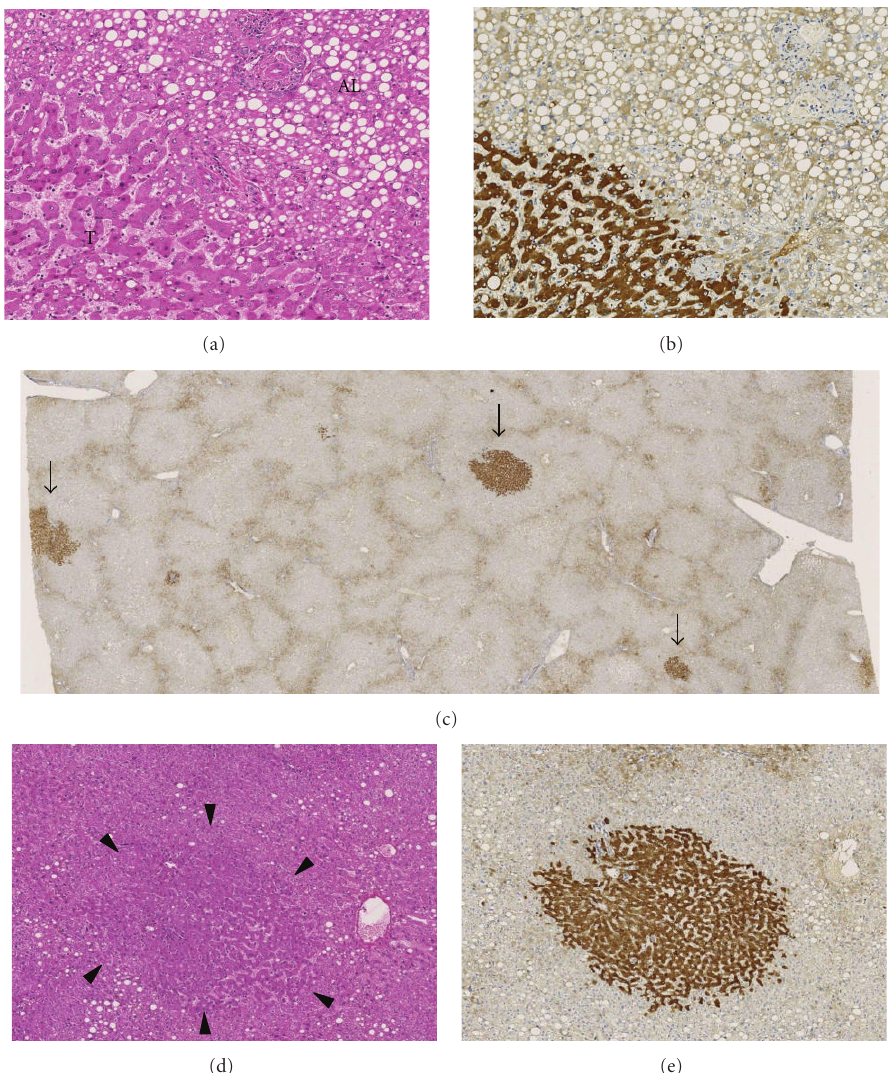
Figure 3: CRP expression in the transitional area and minute CRP-positive foci in a distant sample. (a) The transitional zone of an adenoma without steatosis (T) and steatotic adjacent liver (AL) in hematoxylin-eosin (HE) staining. (b) The same area as (a) in CRP immunostaining showing di ff use increase of CRP in the tumor part. (c) CRP immunostaining of a nontumorous liver sample distant from the tumor showing 3-minute CRP foci (arrows). The preserved architecture of the hexagonal liver lobules is highlighted by the vague expression of CRP which outlines the peripheral boundaries of the lobules. (d) Detail of a minute CRP-positive focus in HE showing an area in the lobule with slightly dilated sinusoids, more eosinophilic hepatocytes, and absence of steatosis which is present outside the contours of this focus (arrowheads). (e) The CRP expression of the focus described in